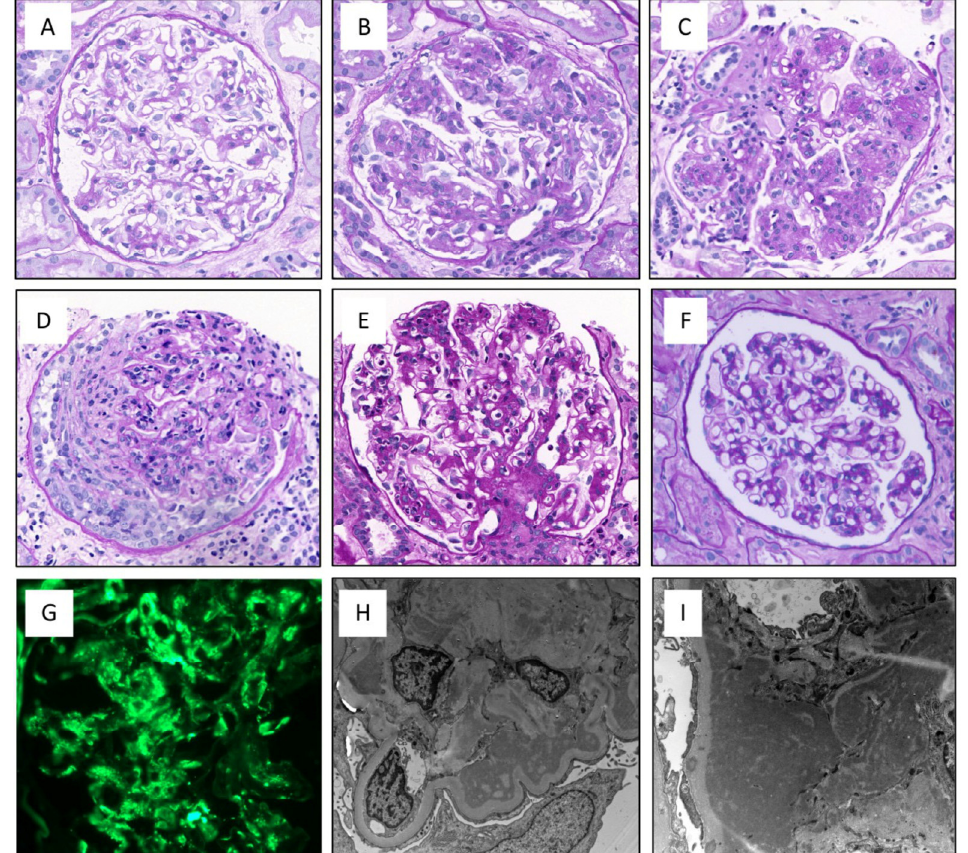
Figure 2. Different morphological features of the index biopsies of IC-MPGN and C3G patients may indicate different activity of the glomerulonephritis (GN) and/or the time point of injury. ( A ) Minimal to mild mesangial expansion, ( B ) mesangioproliferative injury, ( C ) classical membranoproliferative injury with lobular/nodular proliferation and double contours in basement membranes, ( D ) cres- centic injury, ( E ) exudative GN that can be difficult to distinguish from postinfectious GN in the early phase. However, it usually resolves within 3–6 months, whereas C3G or IC-MPGN do not, ( F ) Normal glomerulus for reference, ( G ) IF showing coarse granular C3 positivity in mesangial areas and basement membranes, ( H , I ) Electron-dense deposits on subendothelial and mesangial spaces. ( A – F ) Periodic Acid-Schiff staining, ( G ) frozen section C3 immunofluorescence staining, ( H , I ) electron